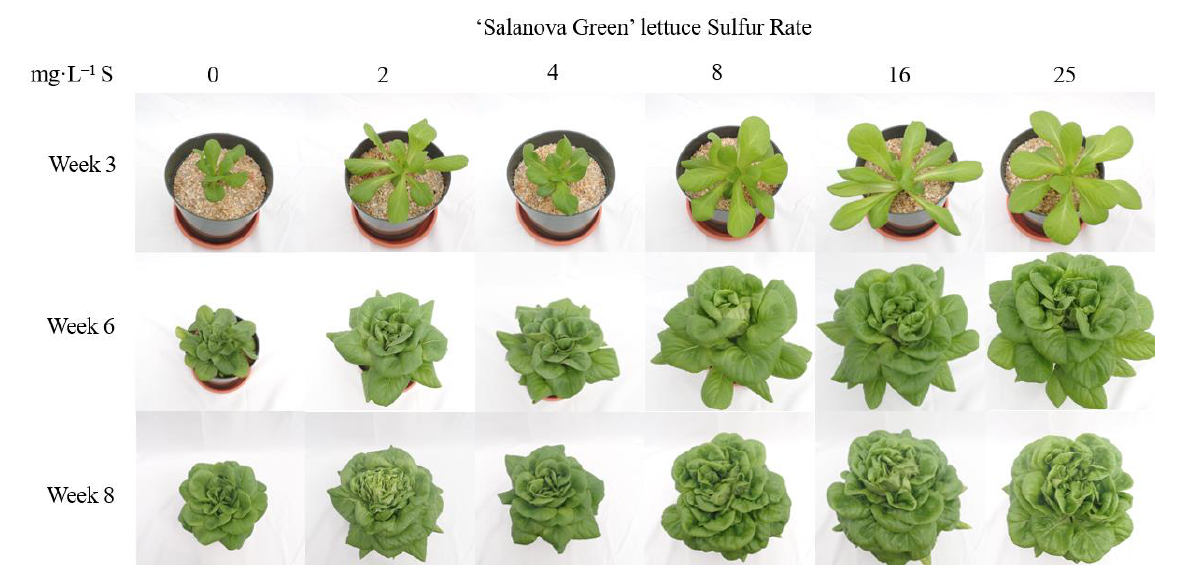
Figure 5. Visual impact of sulfur (S) fertility rate on Lactuca sativa ‘Salanova Green’ at Weeks 3, 6, and 8. Table 6. Impact of sulfur fertility rate on plant dry weight and sulfur leaf tissue concentration on ‘Salanova Green’ lettuce.